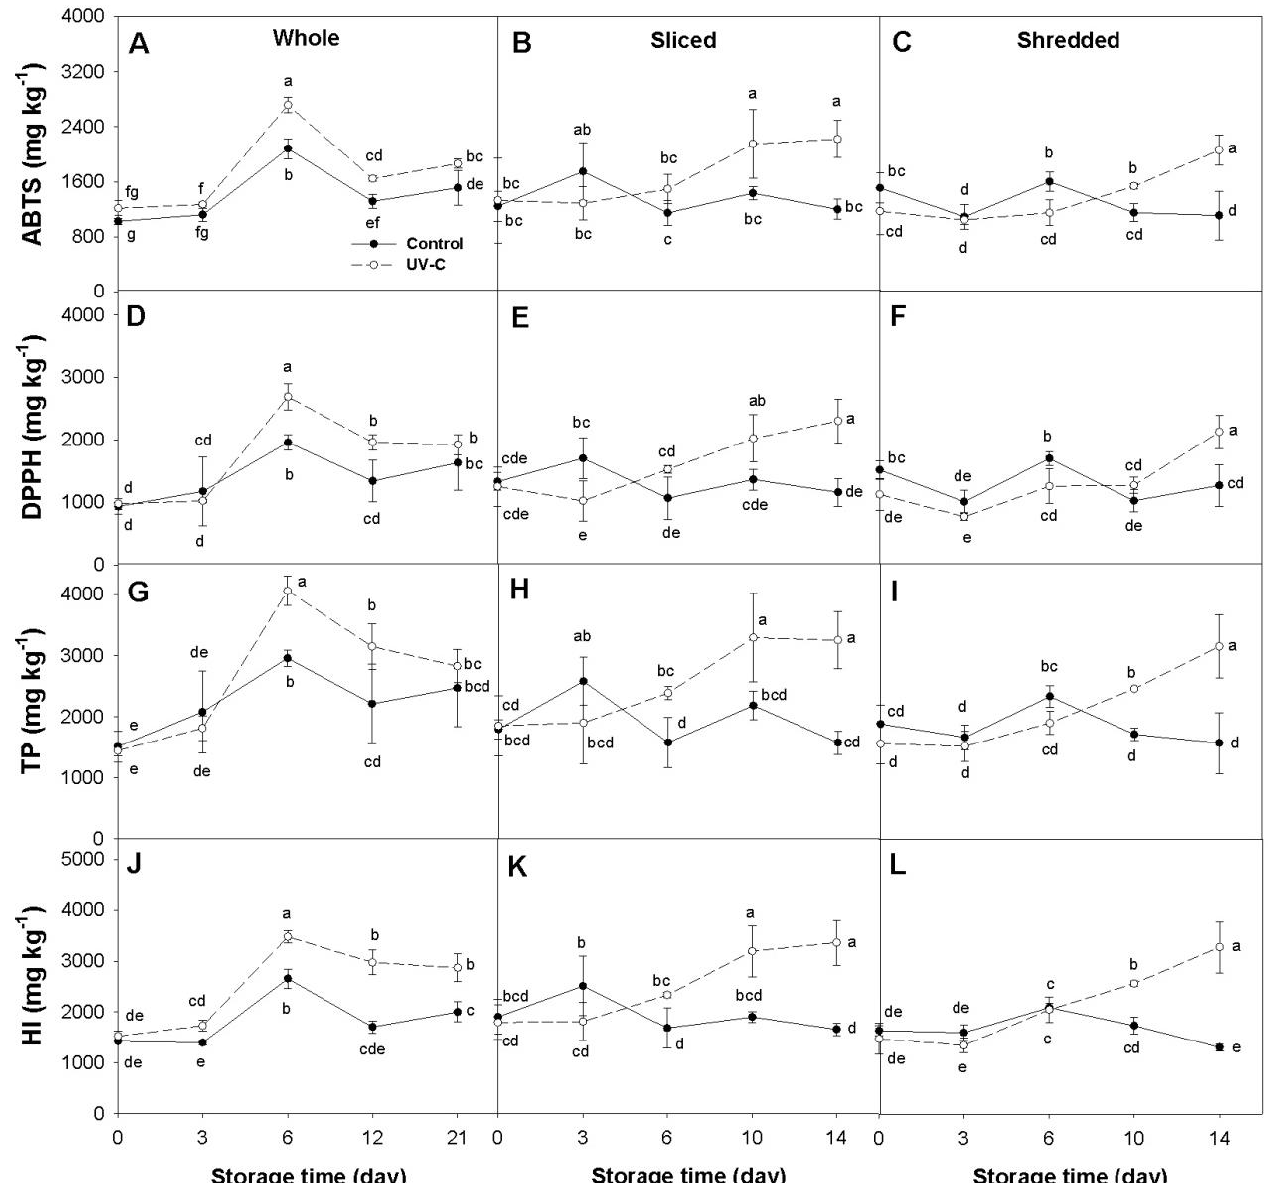
Figure 3. Time-course variation for mean antioxidant capacity determined by the ABTS ( A – C ) and DPPH ( D – F ) methods, concentration of total phenolics (TP) ( G – I ), and hydroxycinnamic index (HI) ( J – L ) for whole ( A , D , G , J ), sliced ( B , E , H , K ), and shredded ( C , F , I , L ) root samples of the purple-rooted cultivar ‘Purplesnax’ during cold storage at 5 ◦ C. Antioxidant capacity is expressed as mg Trolox equivalents per kg fw, whereas TP, HI, and anthocyanin concentrations are expressed as mg × kg − 1 fw. Error bars represent standard deviation of the mean. Means not sharing a common letter are significantly different at p < 0.05, Fisher